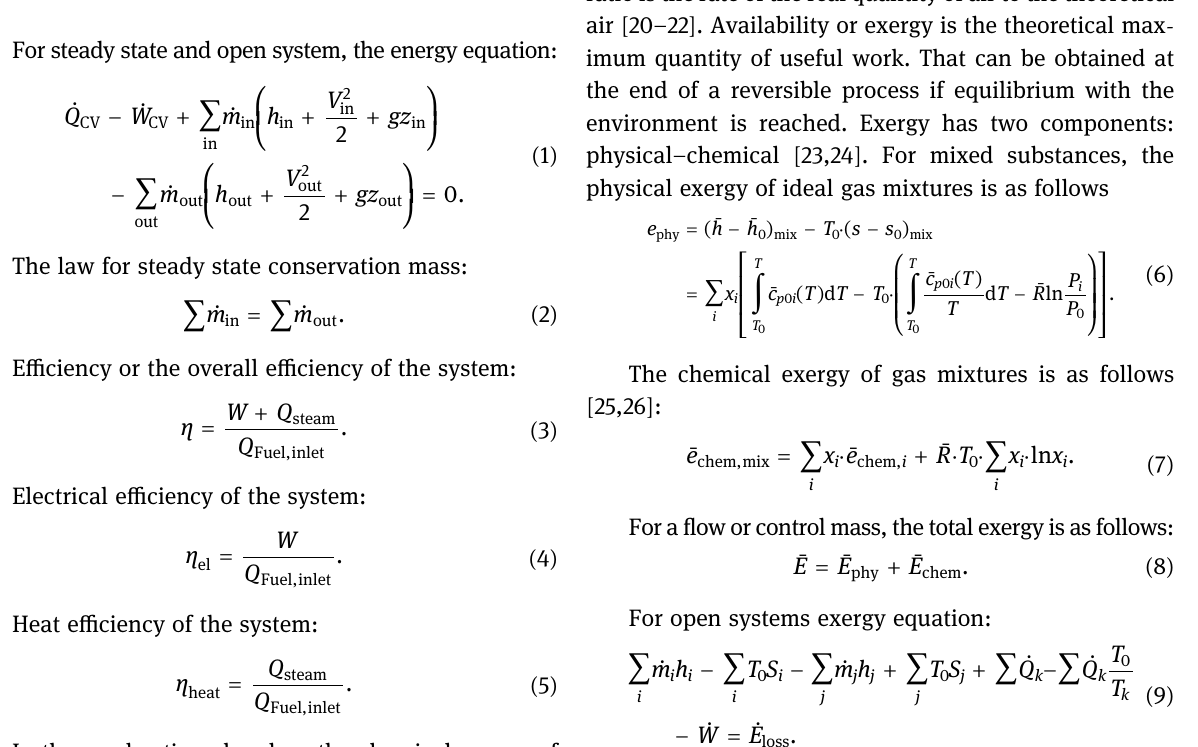
Figure 3: Schema of an air fuel heating ( fah ) cogeneration plant.